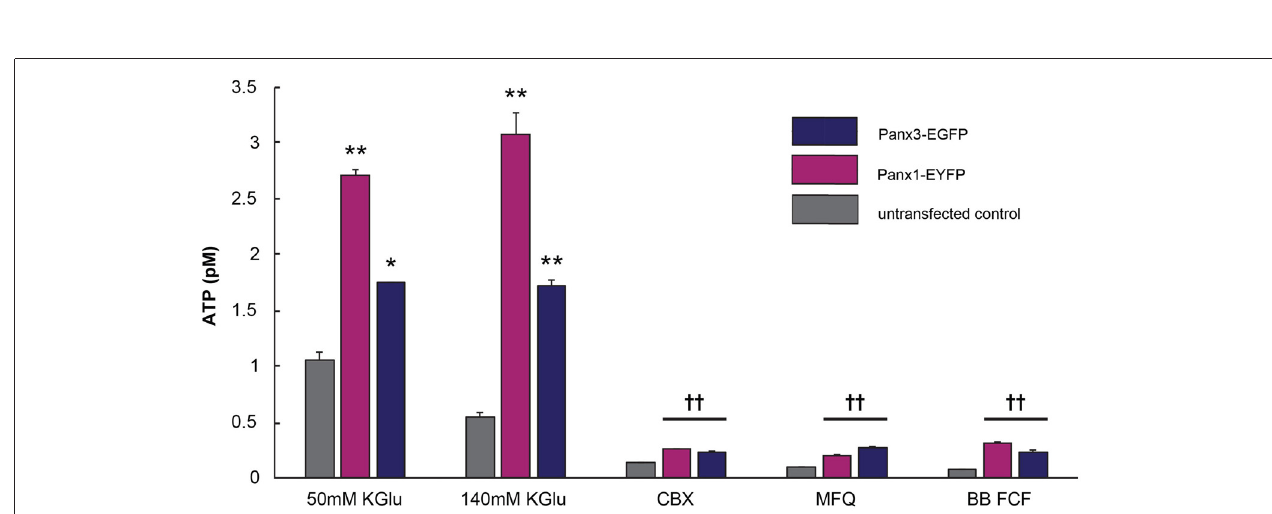
FIGURE 8 | Panx3 has ATP releasing properties like Panx1. Luciferase assay depicting the amount of released ATP by Neuro2A cells that were untransfected (gray) or transfected with mPanx1 (Pink) or mPanx3 (Indigo). Using either medium (50 mM) or high (140 mM) concentrations of potassium gluconate (KGlu) stimulates mPanx1 and mPanx3 to release significantly more ATP compared to Neuro2A cells. Traditional Panx1 blockers carbenoxolone (CBX), mefloquine (MFQ) and brilliant blue food dye (BB FCF) also block mPanx3 and Neuro2a cells when stimulated with 140 mM KGlu prior incubation with the blockers. ∗ Indicate significance compared to Neuro2A controls, ∗ p < 0.001, ∗∗ p < 0001. †† Indicates significance compared to 140 mM KGlu stimulation condition. †† p <